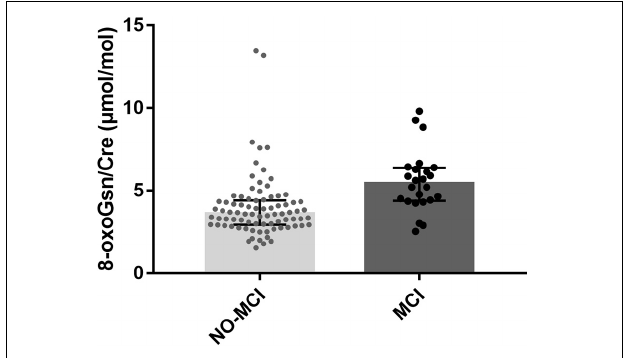
FIGURE 1 | Boxplot for 8-oxoGsn/Cre in the urine samples of NO-MCI and MCI individuals. Error bars represent median with interquartile distance. 8-oxoGsn, 8-oxo-7,8-dihydroguanosine; Cre, creatinine; NO-MCI, Non-mild cognitive impairment; MCI, mild cognitive